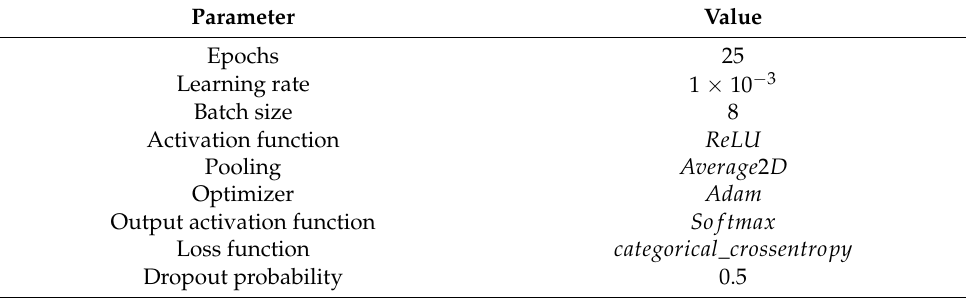
Table 1. Configuration of the CNN